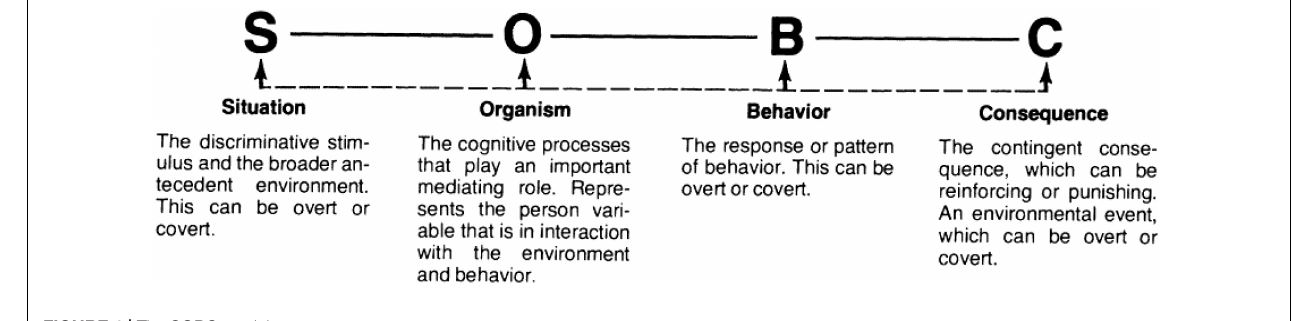
FIGURE 1 | The SOBC model.